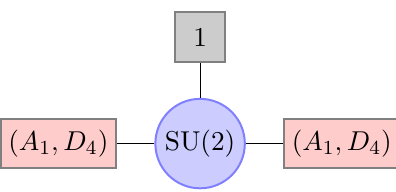
Figure 1 . The quiver diagram describing the ( A 3 ; A 3 ) theory near a cusp in the conformal manifold. The top box with 1 in it stands for a fundamental hypermultiplet of SU(2), and the left and right boxes stand for two copies of the ( A 1 ; D 4 ) theory. The middle circle stands for an SU(2) vector multiplet which gauges the diagonal SU(2) (cid:13)avor symmetry of the three sectors. ( A ; D ) theory. 7 Since the beta function of this gauging vanishes, the whole theory is 1 4